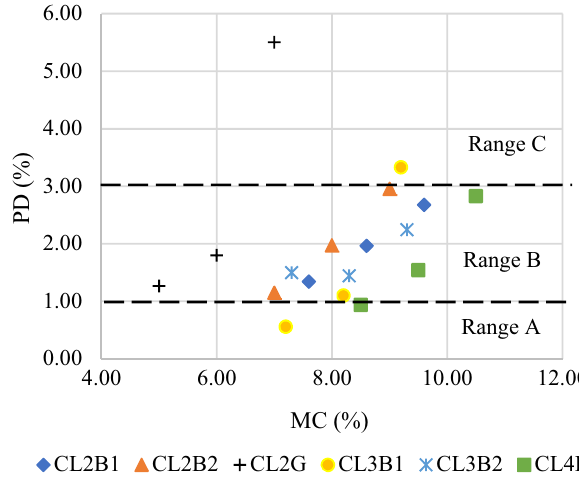
(a) PD at different moisture contents